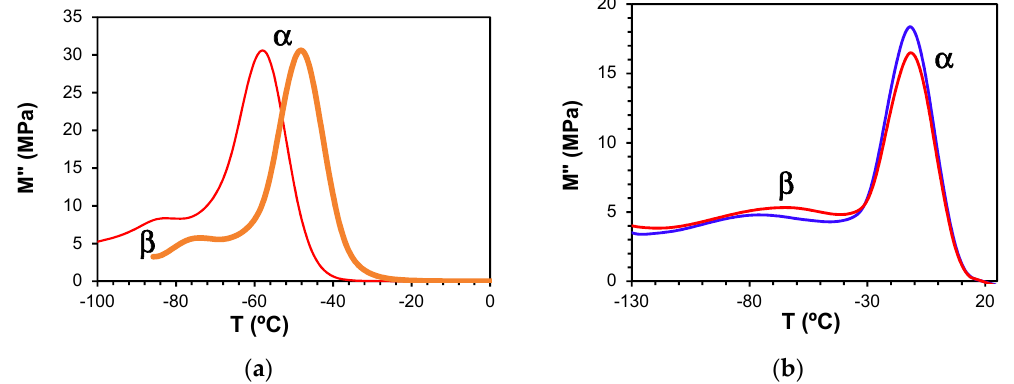
Figure 14. Loss modulus obtained by DMA at the heating rate of 2 °C/min for the systems studied: ( a ) PEI800 (red) and PEI25000 (brown) at 0.1 Hz; ( b ) uncured ELP800 (blue) and uncured ELP25000 (red) at 1 Hz.